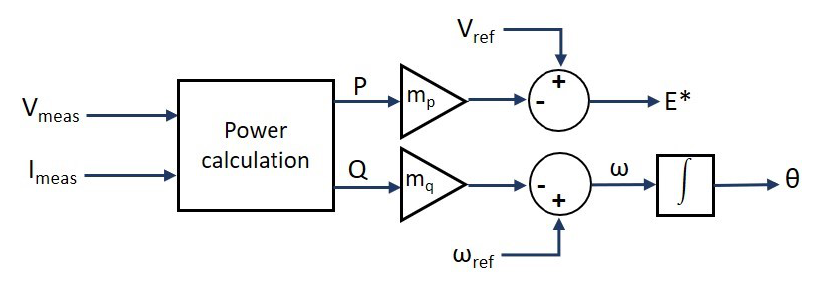
Figure 2. Droop control block diagram